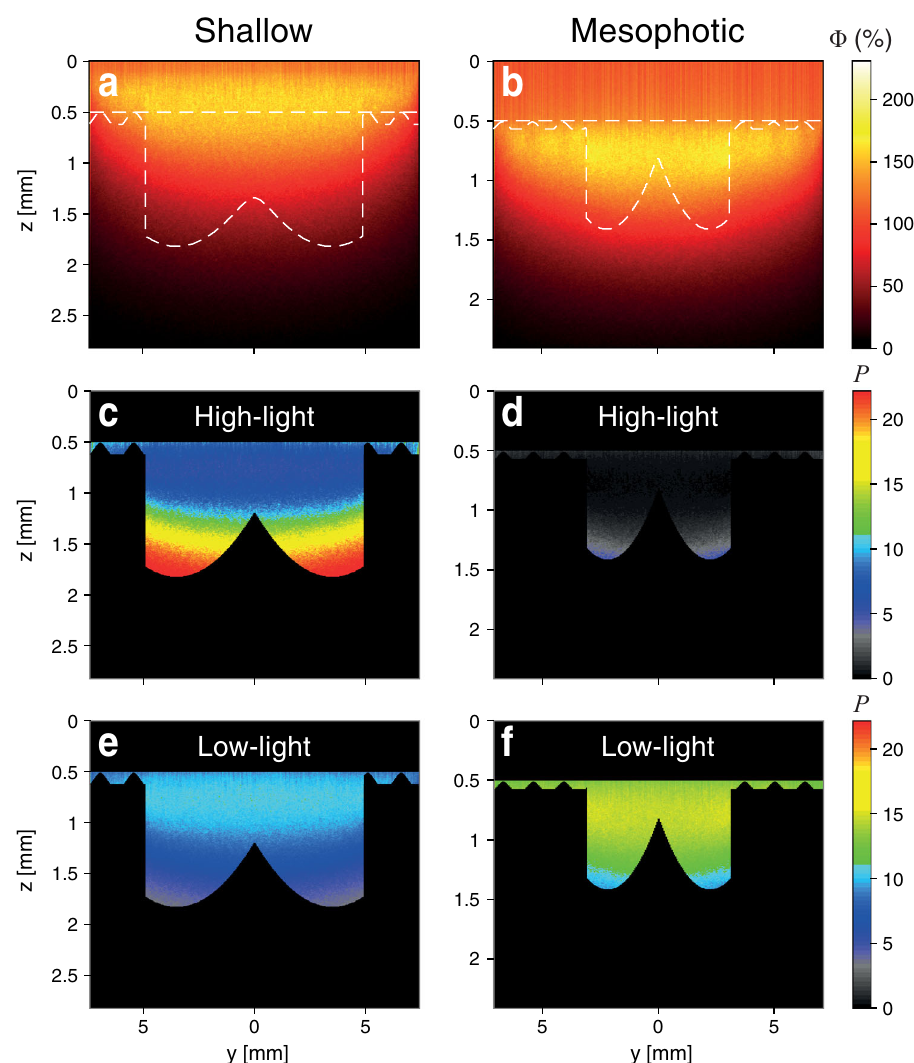
Fig. 5 Examples of light propagation simulations shown in 2D ( y -z axes). Examples of light propagation simulations shown in 2D ( y - z axes) for simplicity (see scores normalized per tissue pixel for all 112 scenarios in Fig. 6). a , b Relative fl uence rates ( Φ ; delivered as W m − 2 ; as “ fi re ” color gradient) with contour indicating the surface boundaries of shallow and mesophotic natural morphotypes. c – f Photosynthetic score ( P ; as “ rainbow ” color gradient) on the tissue layer of shallow and mesophotic architectures with default settings under light intensities of 750 (high-light) and 45 (low-light) µ mol photons m − 2 s − 1